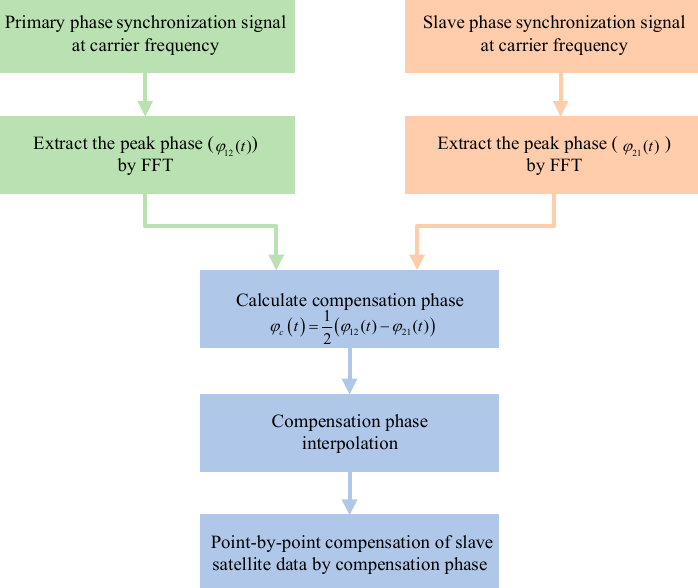
Figure 3. The flow diagram of synchronization signal processing.